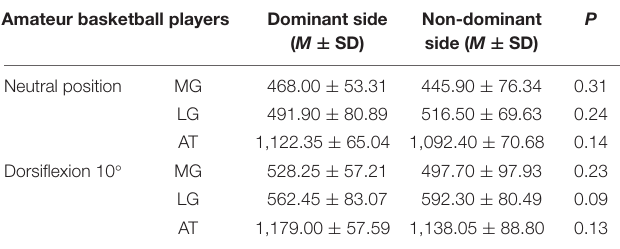
TABLE 2 | The stiffness of the medial gastrocnemius (MG), lateral gastrocnemius (LG), and Achilles tendon (AT) in amateur basketball players.